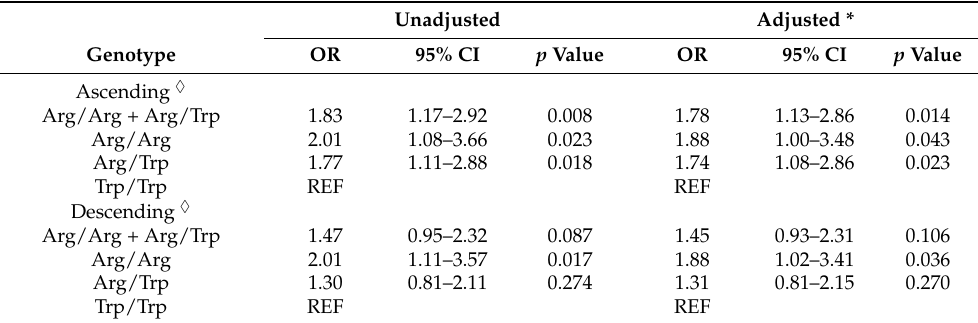
Table A6. Association of KIF6 719Arg with ascending and descending thoracic aortic dissection (only typical cases).